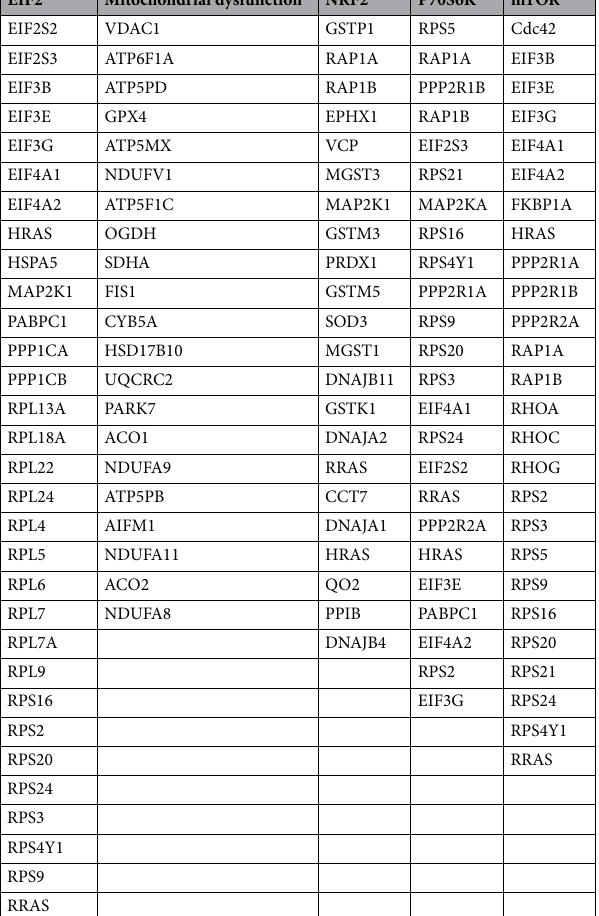
Table 1. Shared proteins in the menisci of ground control and vivarium control vs flight mice that are clustered within differential canonical pathways between both controls and flight determined via ingenuity pathway analysis. Listed proteins are significantly different in both GC and VIV vs FLIGHT with a fold change of 1.5 or greater ( p <